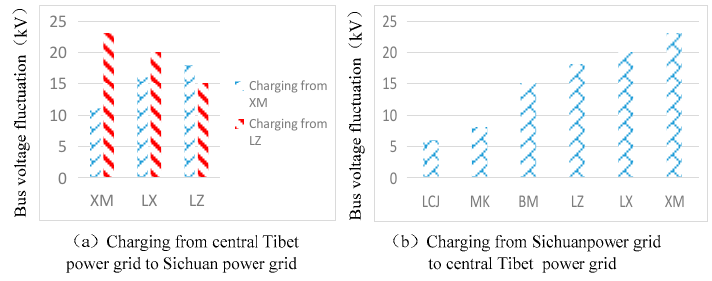
Figure 2. E ff ect of switching single reactor on system voltage.